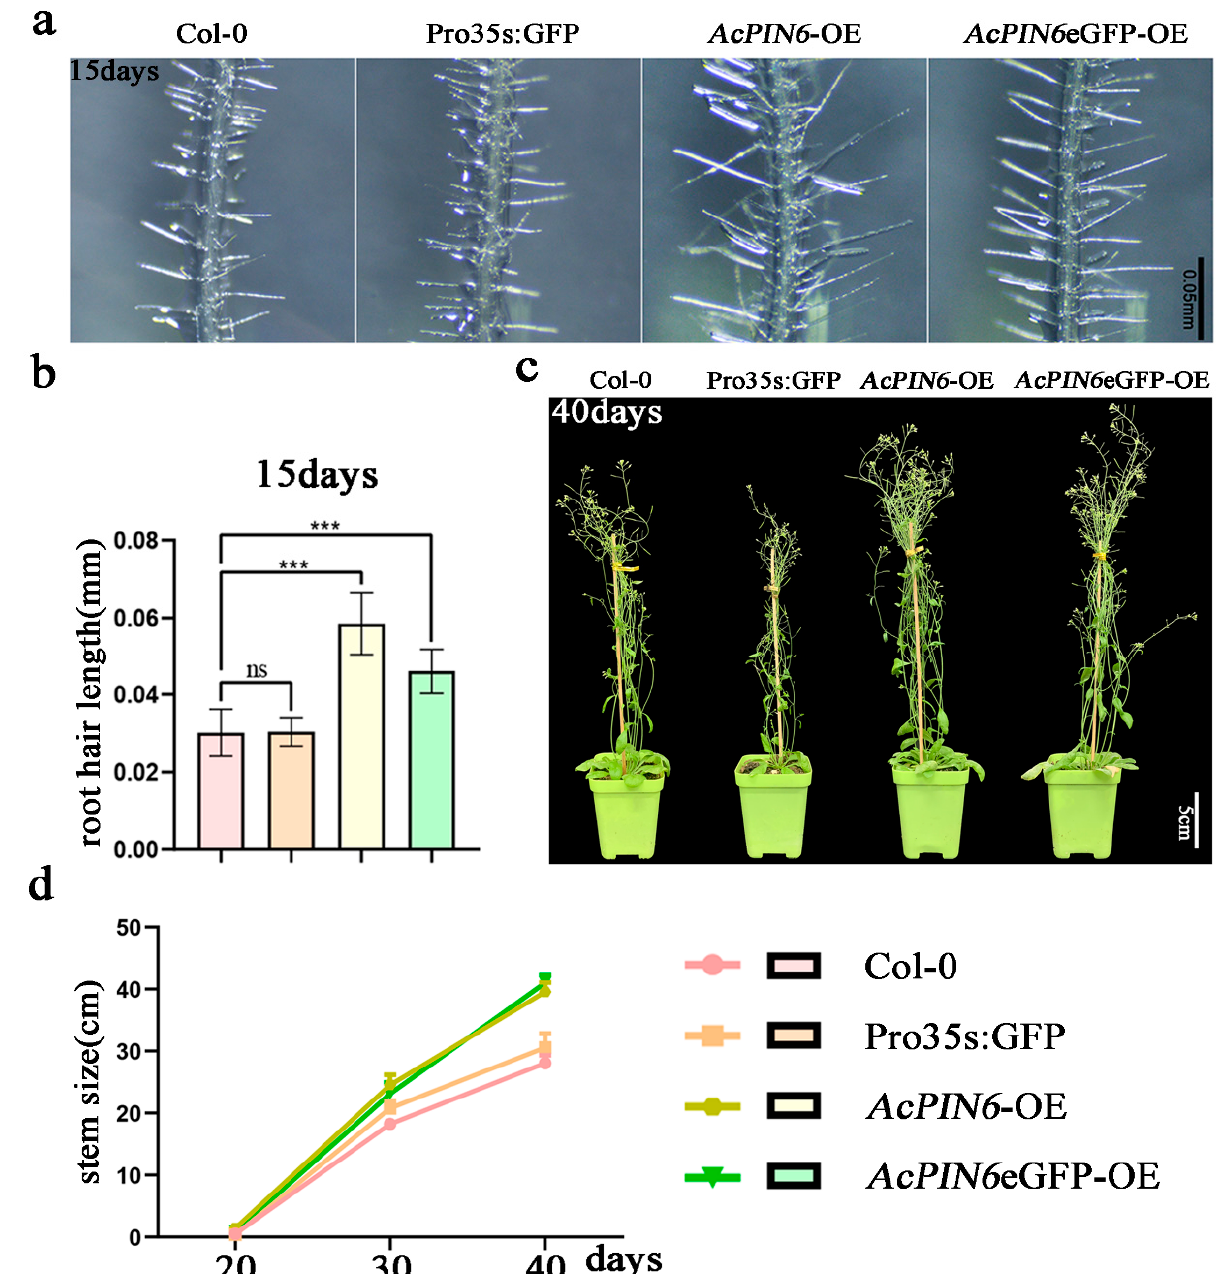
Figure 6. Phenotype of Arabidopsis overexpressing AcPIN6. ( a ) AcPIN6 -overexpression root hair phenotype in Arabidopsis at 15 days. ( b ) Main root hair length (mm) at 15 days. ( c ) AcPIN6 -overexpression phenotype in Arabidopsis grown for 40 days. ( d ) Plant height (cm) from 20–40 days. Error bars represent mean ± SE from three independent experiments (ns: p > 0.05; *** p < 0.001).